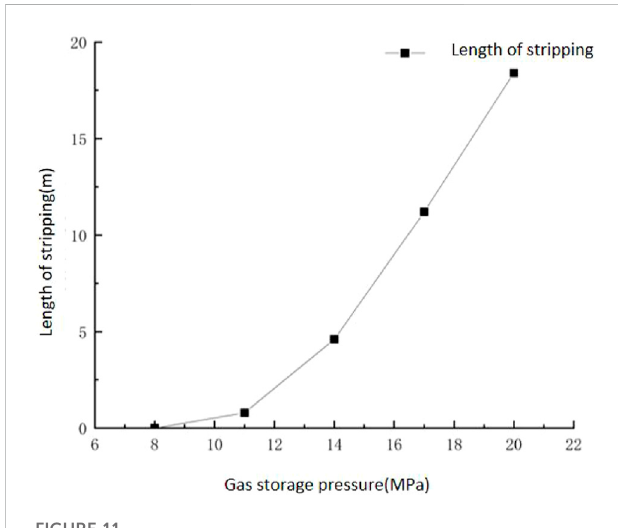
FIGURE 11 The stripping length varies with the gas storage pressure.